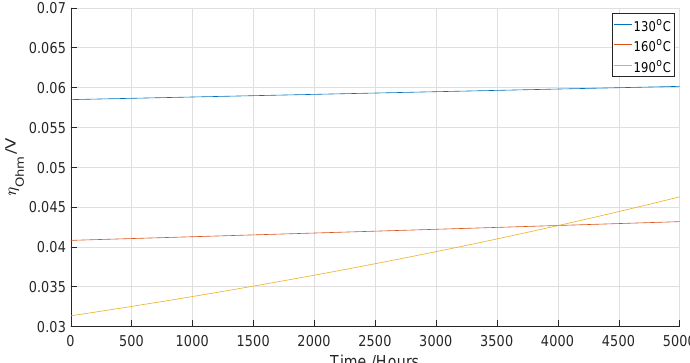
Figure 7. Ohmic overpotential over time as a function of temperature.